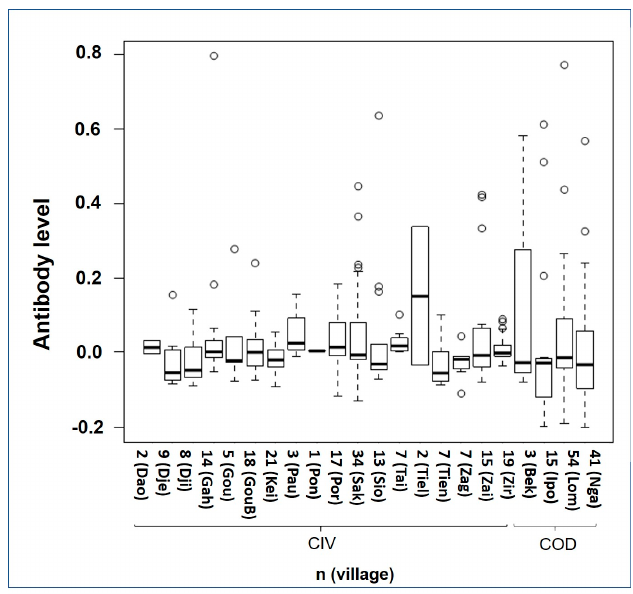
Figure 4. Mean antibody levels in the villages where specimens were taken. The names of the villages are abbreviated to the first three or four letters of the name. The first 18 villages on the left are in CIV, the 4 on the right hand side represents villages in COD.